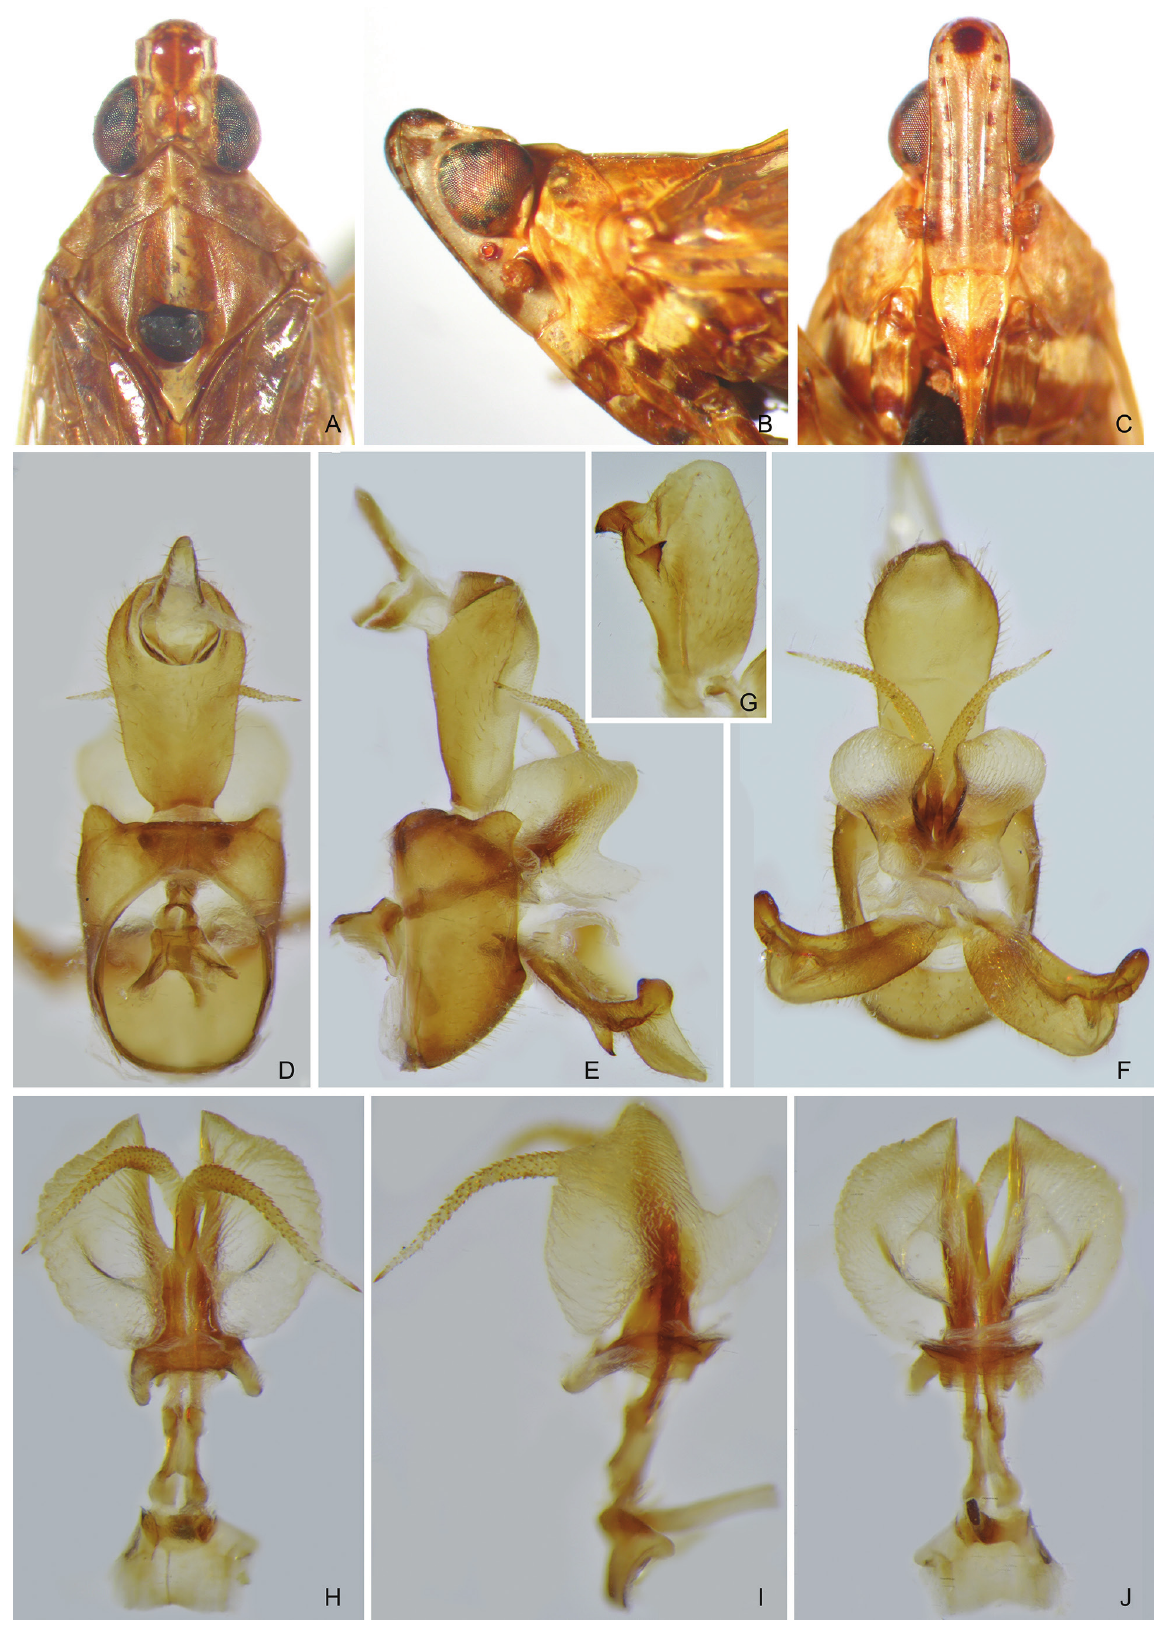
Figure 9. Orthopagus philippinus Melichar. ( A ) Head, pronotum and mesonotum, dorsal view. ( B ) Head and pronotum, lateral view. ( C ) Head and pronotum, ventral view. ( D ) Male segment X and pygofer, dorsal view. ( E ) Male pygofer, gonostyles, and segment X, lateral view. ( F ) Male pygofer and gonostyles, caudal view. ( G ) Gonostyle; ( H ) Aedeagus, dorsal view. ( I ) Aedeagus, lateral view. ( J ) Aedeagus, ventral